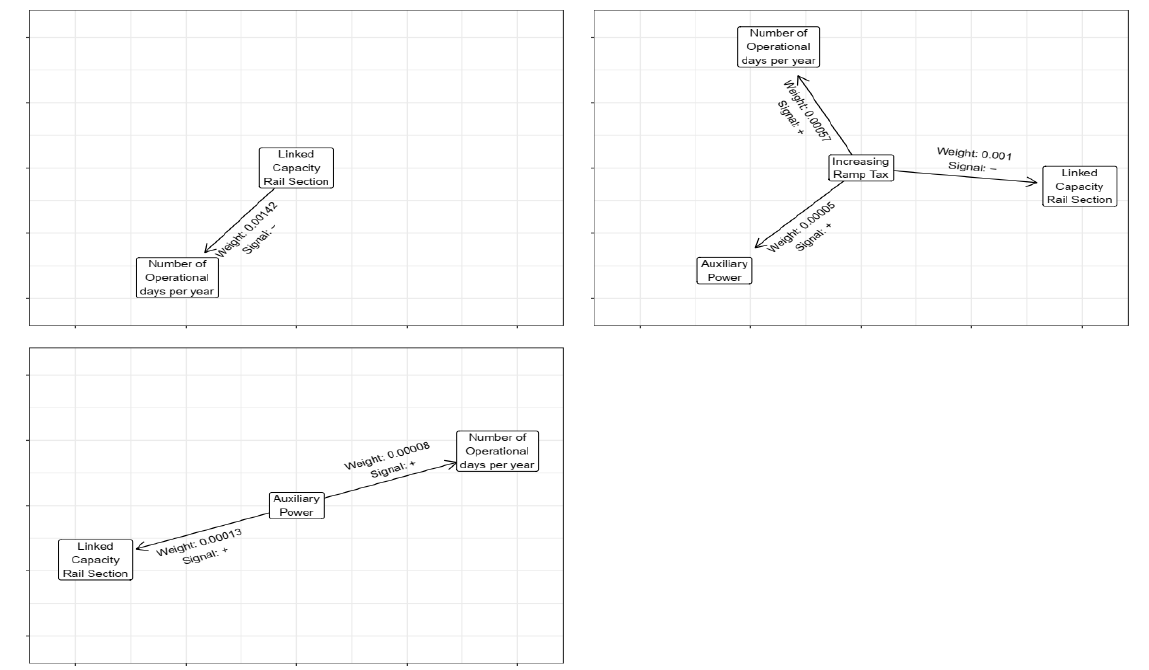
Figure 11. Cause and effect framework for selected attributes at 0.975 percentile (weights are derived from step 2, signs are derived from Olden and Jackson’s (2002) [48] sensitivity analyses).